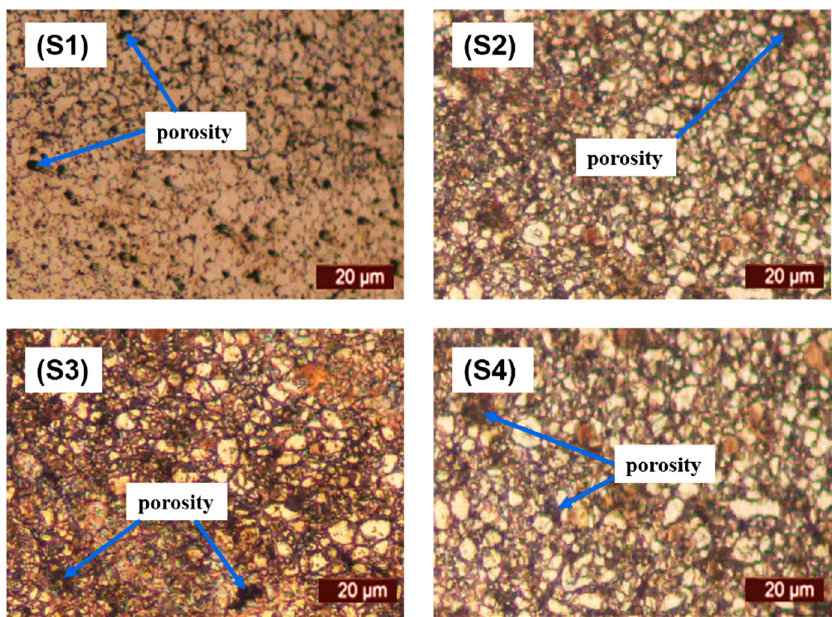
Figure 4. Microstructure of sintered samples ( S1 – S4 ).